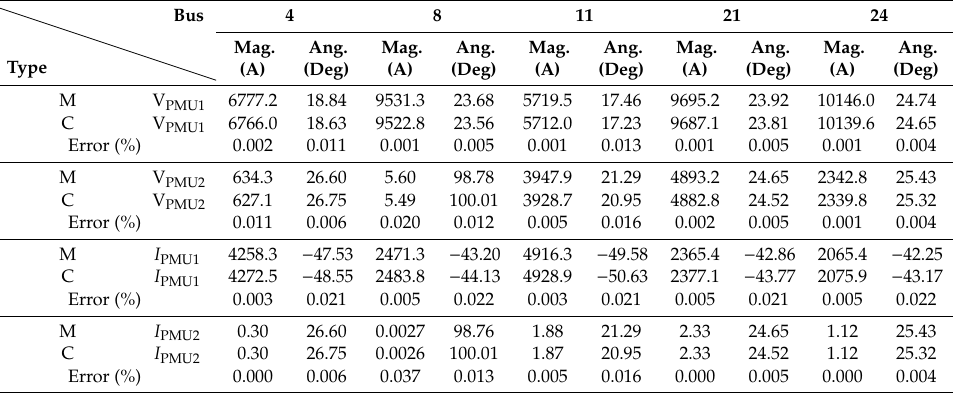
Table 8. Comparison between the fault analysis and Matlab